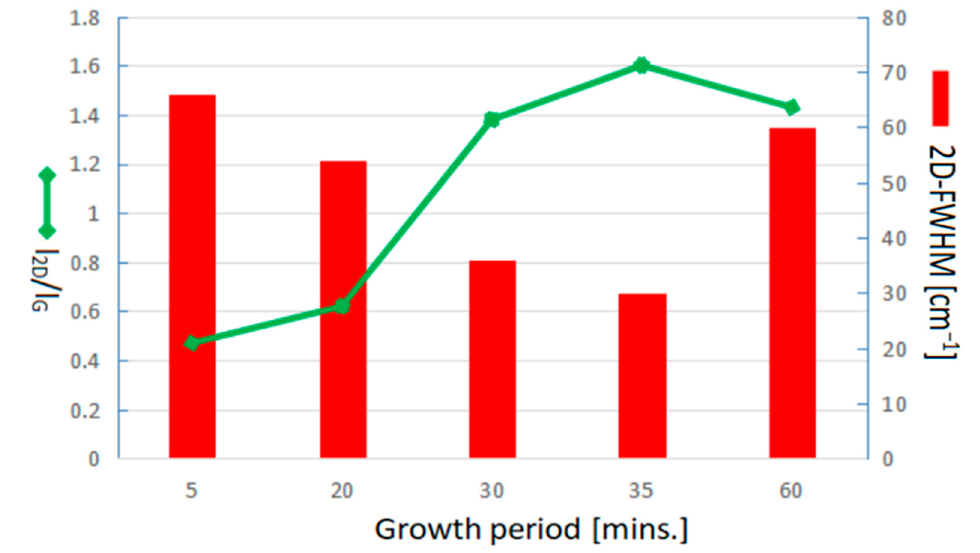
Figure 7. Comparison of I 2D /I G ratio and 2D-FWHM value of Raman pattern corresponding to the graphene growth period of 5, 20, 30, 35, and 60 min in accordance with Raman spectra of Figure 6.